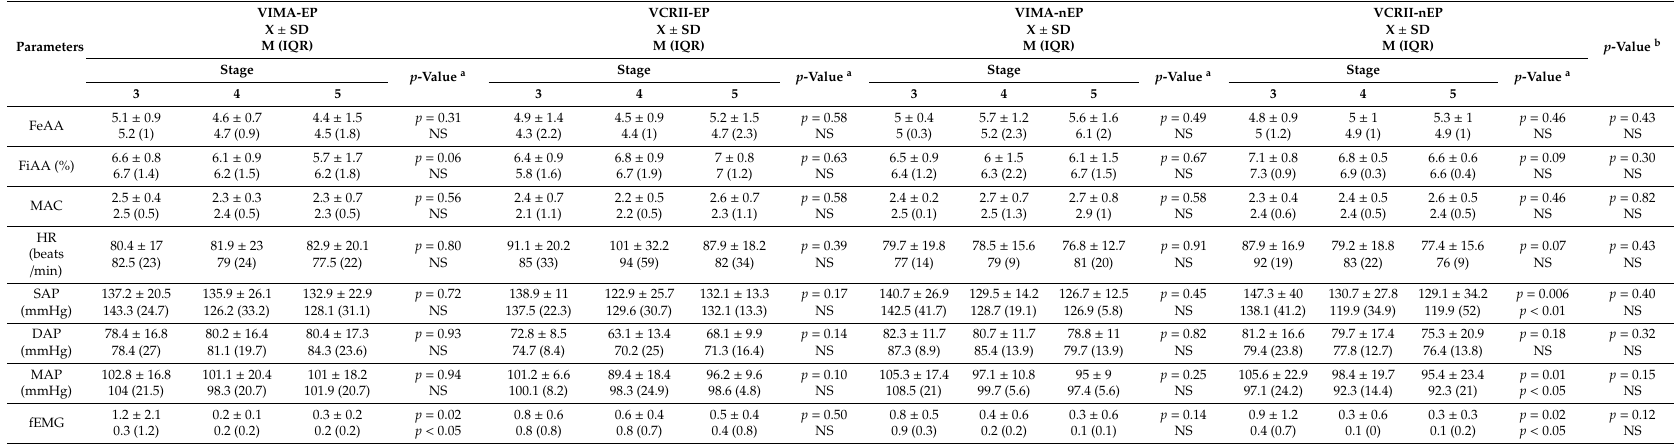
Table A2. Comparison of values of monitored patients’ parametres between di ff erent stages of volatile induction of general anaesthesia in studied groups of patients.